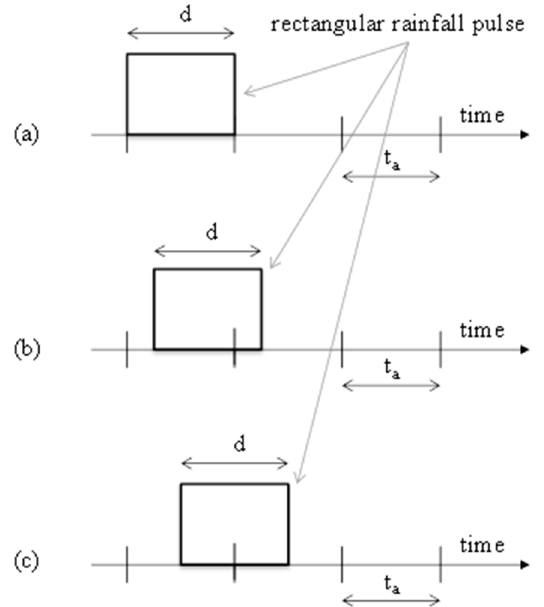
Figure 2. Representation of a generic rainfall pulse characterized by duration, d , equal to the measurement temporal resolution, t a . ( a ) Case where a correct determination of the annual maximum rainfall depth of duration d , H d , is possible. ( b ) Case with a generic underestimation of H d . ( c ) Case with the maximum underestimation of H d (50%).